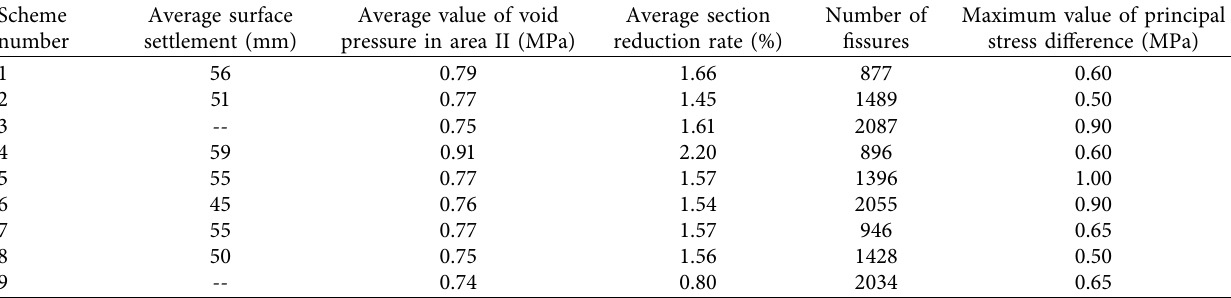
Table 4: Comparison of grouting reinforcement effect in various simulation schemes.